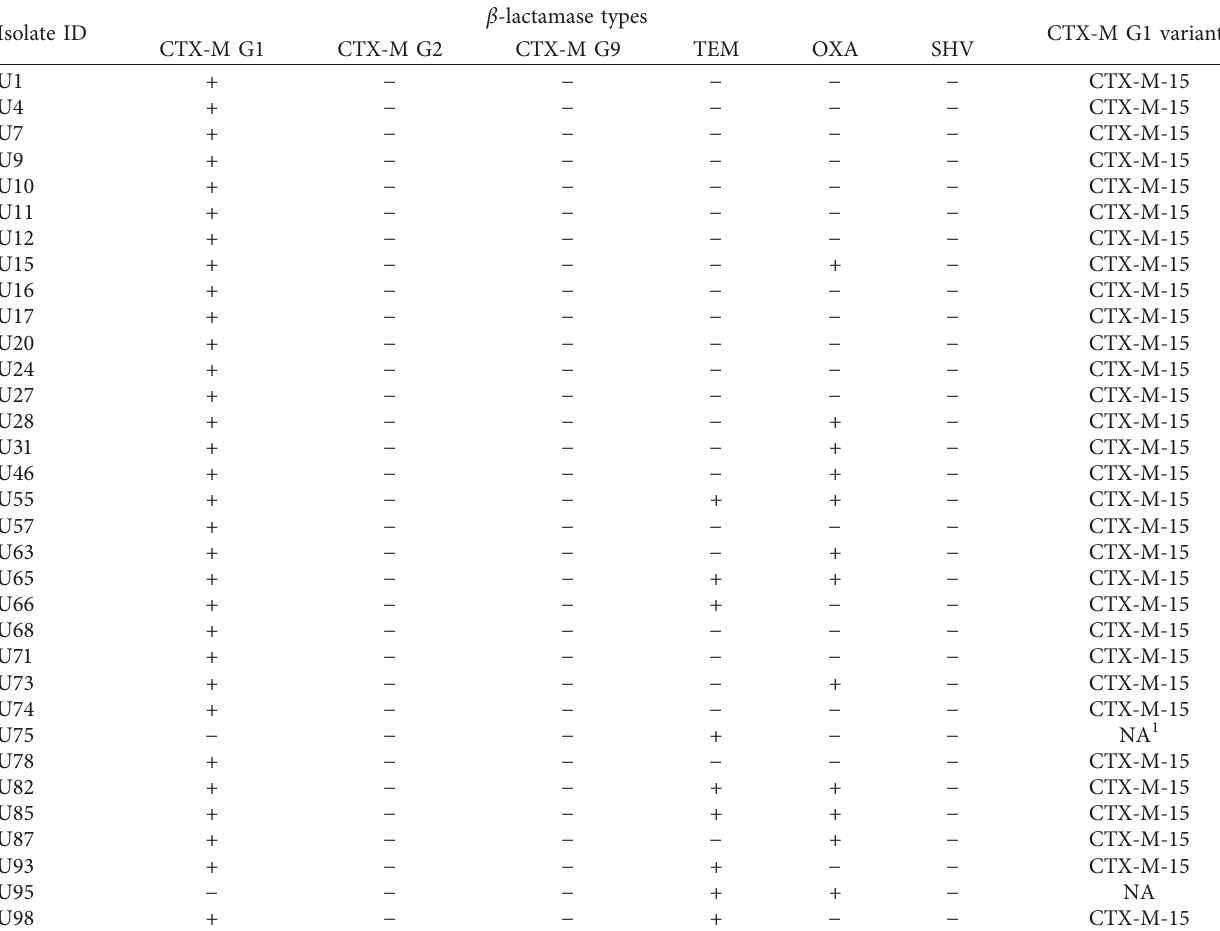
Table 5: The distribution of β -lactamase genes among ESBL-producing E. coli